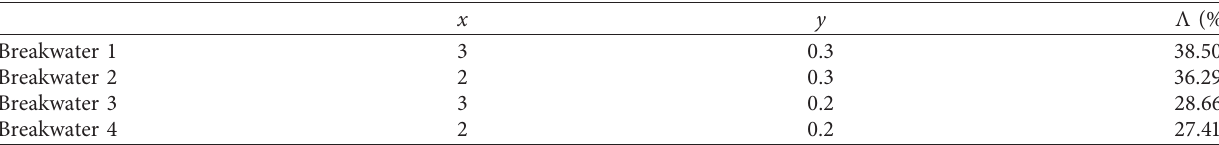
Table 13: Damping energy capability Λ for different breakwaters.